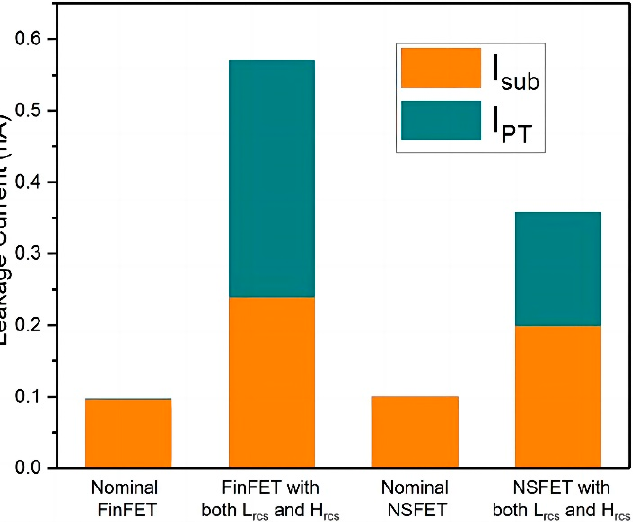
Figure 8. Off-state electron energy band distribution along the channel direction at ( a ) 3 nm (1/2 × 6 nm) and ( b ) 9 nm (1/2 × 18 nm) below the shallow trench isolation (STI) respectively.